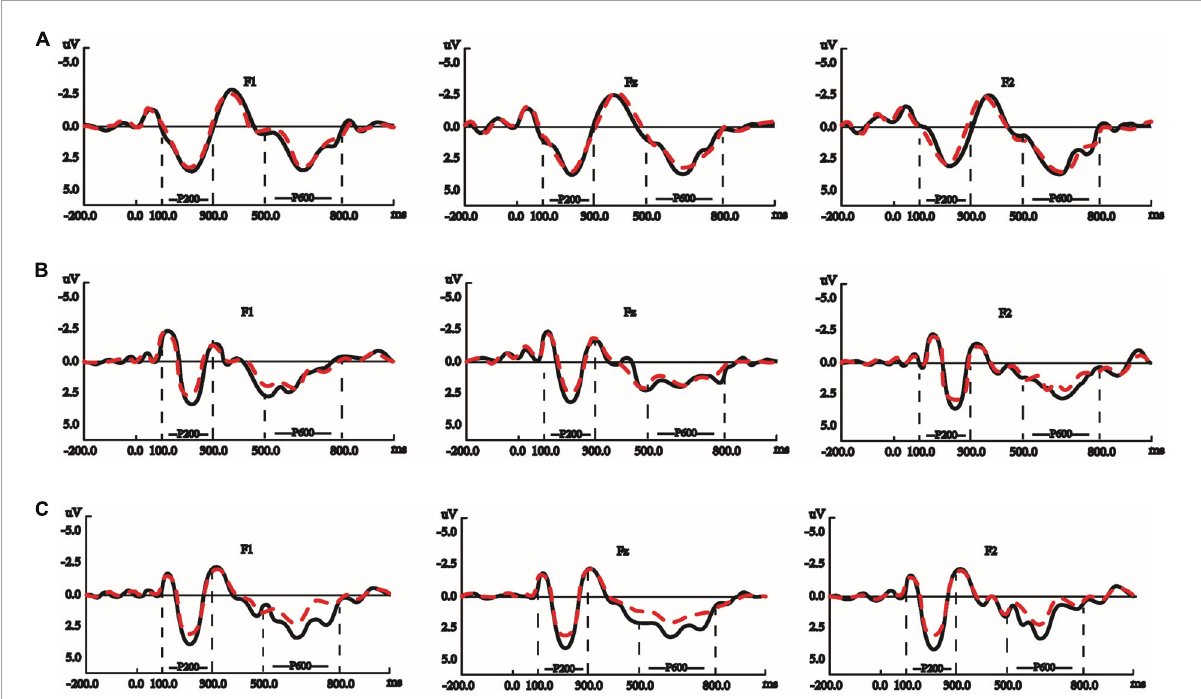
FIGURE4 (A) Native signers with low L2Level did not possess significantly dissociated P200 or P600 effect between processing noun (red dashed lines) and verb (black solid lines) in written Chinese sentences. The y-axes in these panels are negative up. (B) Native signers with mid L2Level possessed significantly dissociated P200 but not P600 effect between processing noun (red dashed lines) and verb (black solid lines) in written Chinese sentences. The y-axes in these panels are negative up. (C) Native signers with high L2Level possessed significantly dissociated P200 and P600 effects between processing noun (red dashed lines) and verb (black solid lines) in written Chinese sentences. The y-axes in these panels are negative